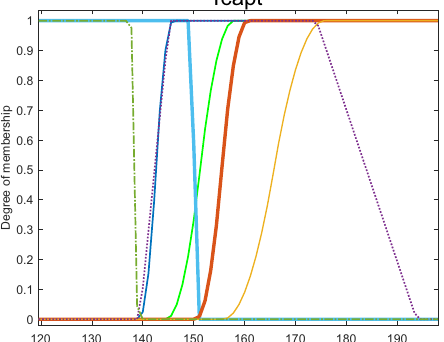
Figure 12. Inputs memberships functions of variable T capt .